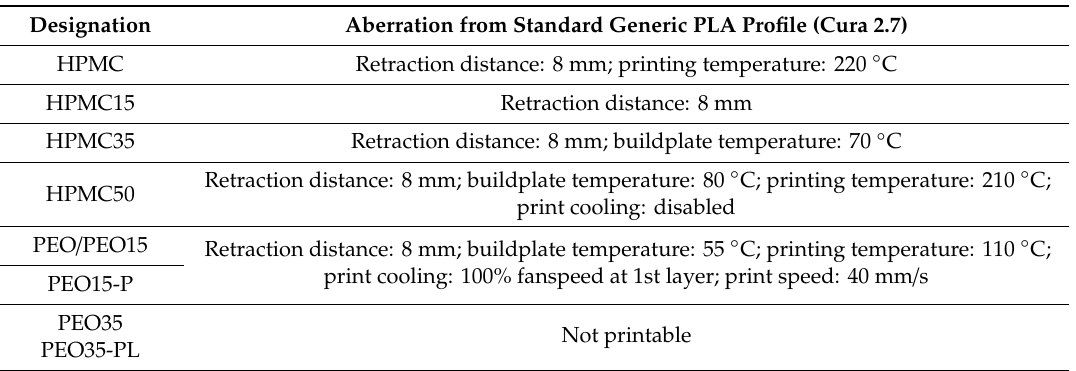
Table 2. Specific printing parameter deviating from Cura generic PLA profile for every